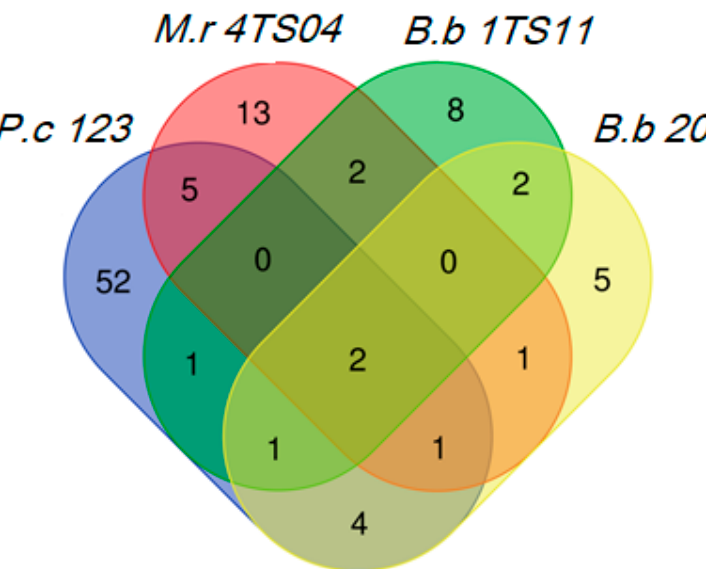
Figure 2. P. chlamydosporia 123 is the fungus that produces the most VOCs, followed by M. robertsii 4TS04. Only two compounds are produced by all the fungi analyzed by SPME ‐ GC/MS.